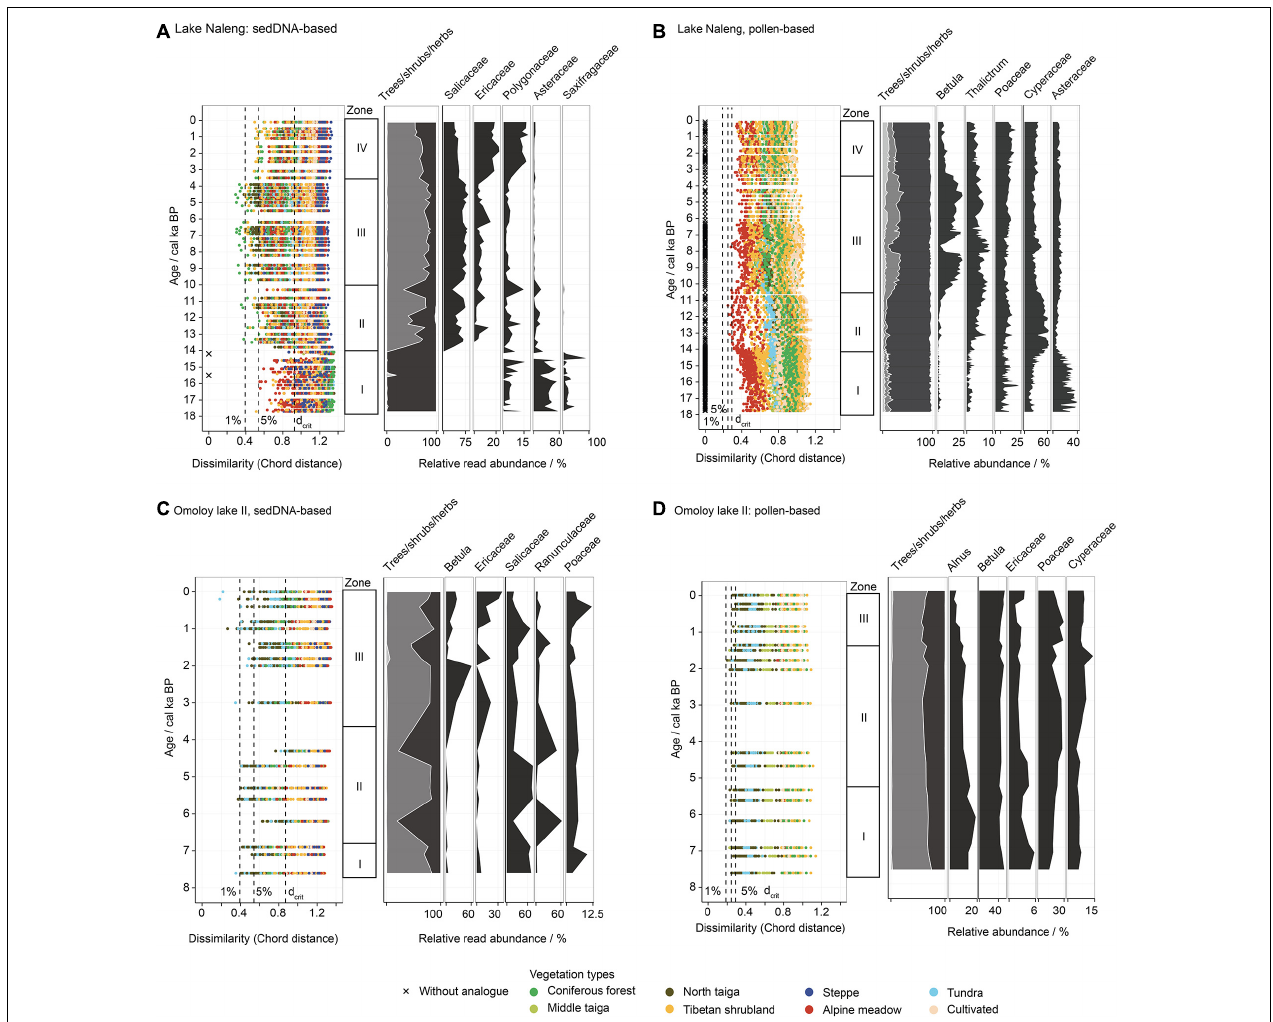
FIGURE 5 | Comparison of reconstructed vegetation types based on sedDNA (left) and pollen (right) from Lake Naleng (A,B) and Lake Omoly II (C,D) . Vertical dashed lines mark dissimilarity of 1, 5%, and the optimal dissimilarity threshold ( d crit ). Stratigraphic diagrams (right side of each panel) show the relative abundance of trees, shrubs, and herbs and the top five abundant taxa. Zones are classified based on